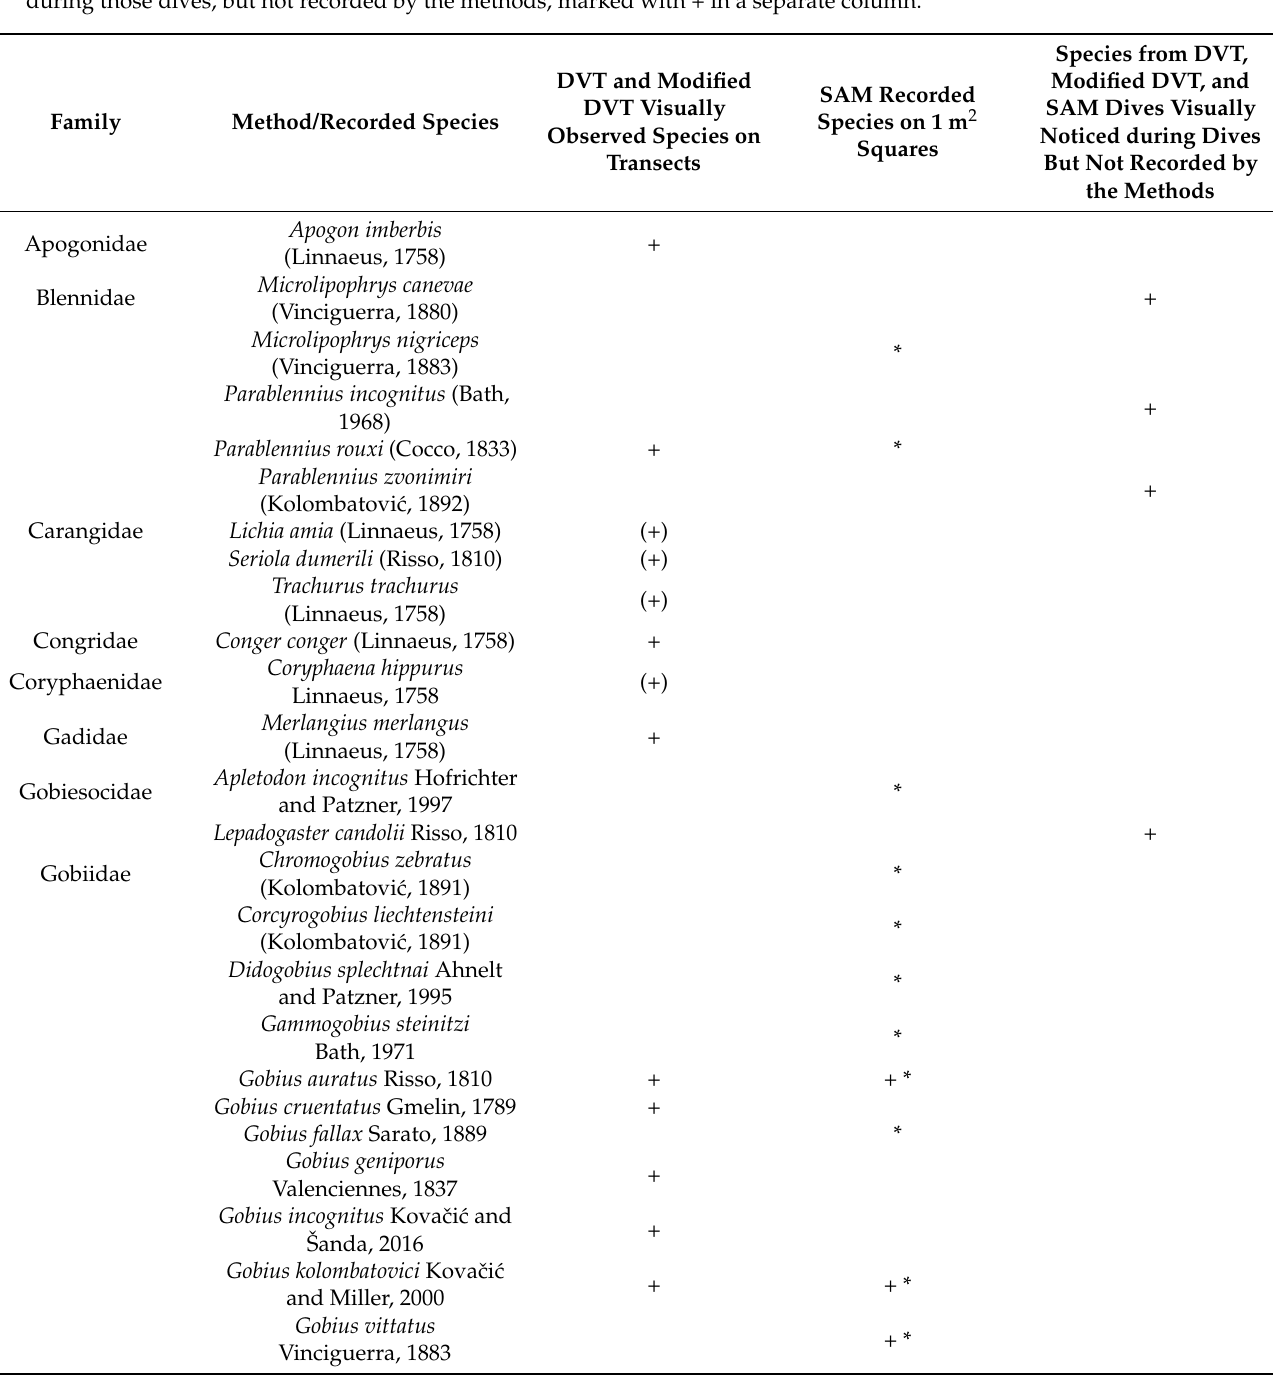
Table 1. Species recorded by DVT method: + reef-associated species or species which permanently occupy the coralligenous surface or habitats around the reef base (sandy), (+) occasional species or species which are mainly active and more mobile predators that use reef as feeding areas. Species recorded by SAM: + visually observed specimens on 1 m 2 squares, * specimens collected with anesthetics on 1 m 2 squares. Species from DVT, modified DVT, and SAM dives visually noticed during those dives, but not recorded by the methods, marked with + in a separate column. Family Method/Recorded Species